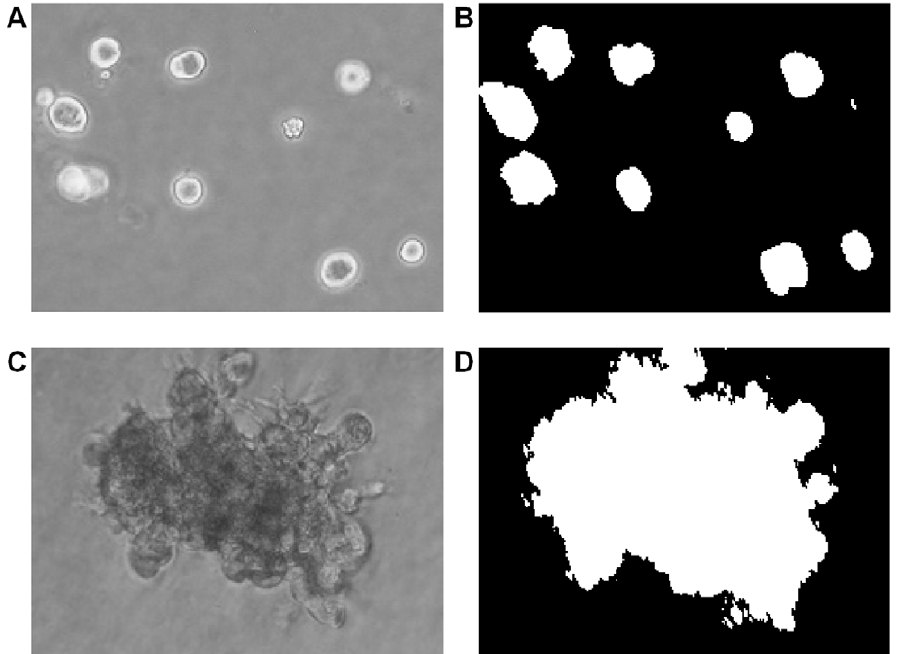
Figure 9. Regions associated with the multicellular colonies are differentiated through proposed computational method. (a)(c) original images of two types of colonies with contrast reversal (e.g., dark regions in the bottom row versus bright regions in the top row), and (b)(d) the corresponding segmented results. Segmentation is feasible as a result of the Gabor filter bank that encodes oriented texture features.